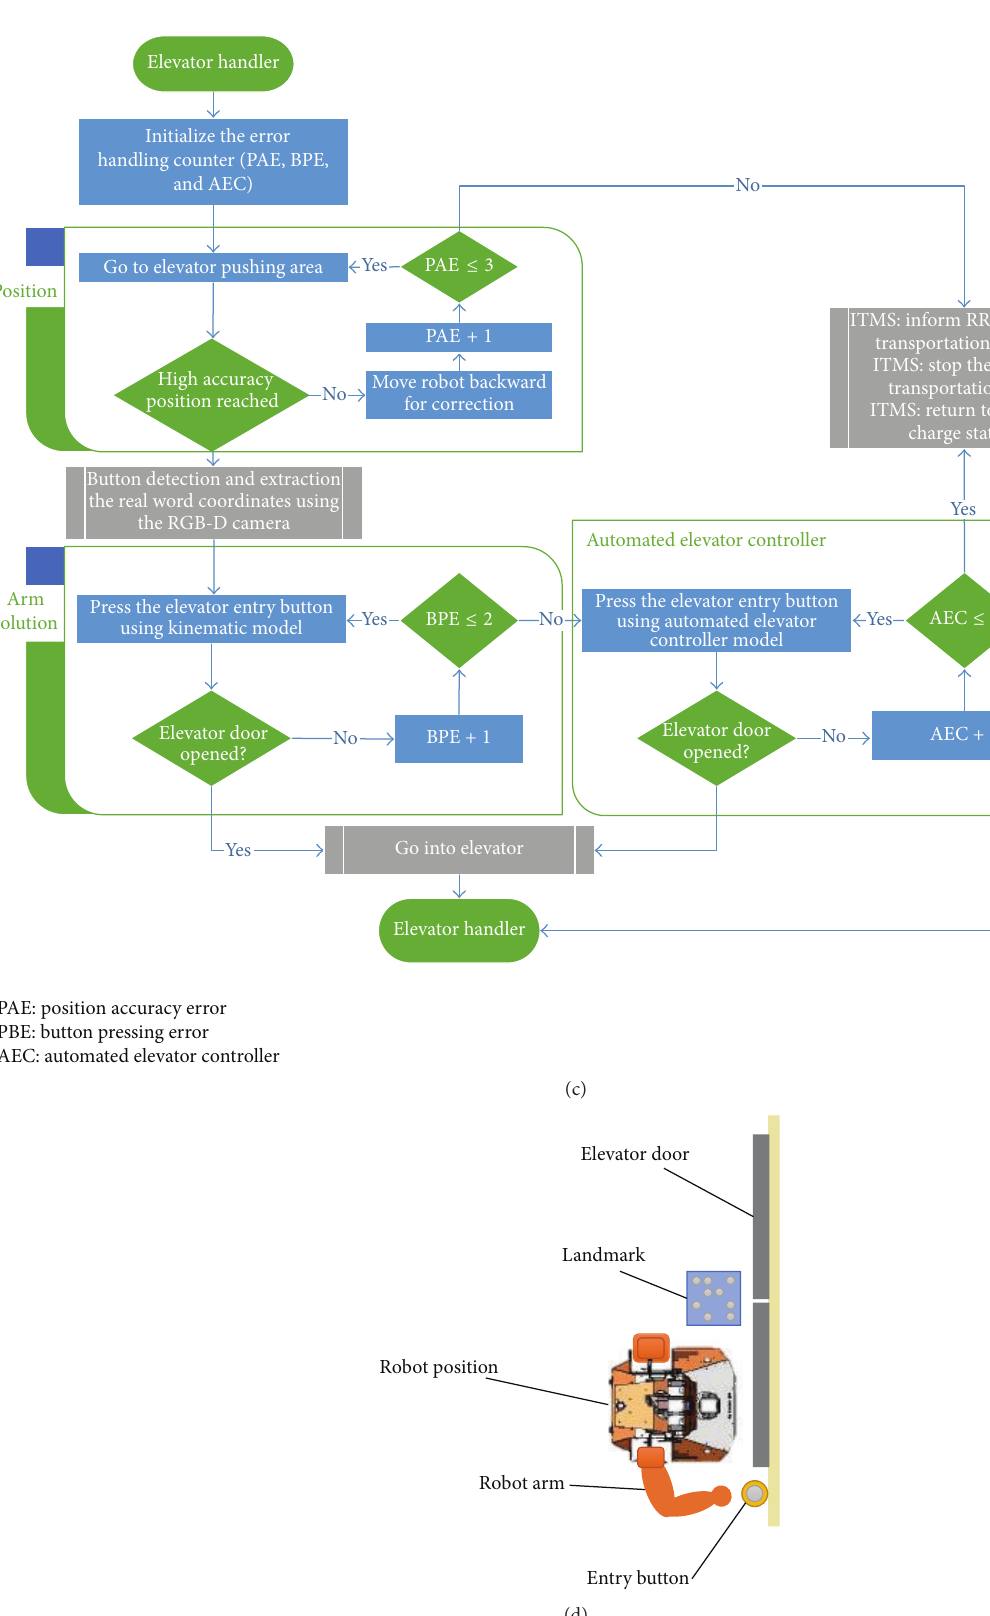
Figure 7: Robot-elevator door controlling case. (a) HSL based entry button detection flow chart. (b) Internal buttons detection flow chart. (c) Button pressing flow chart. (d) Robot and elevator